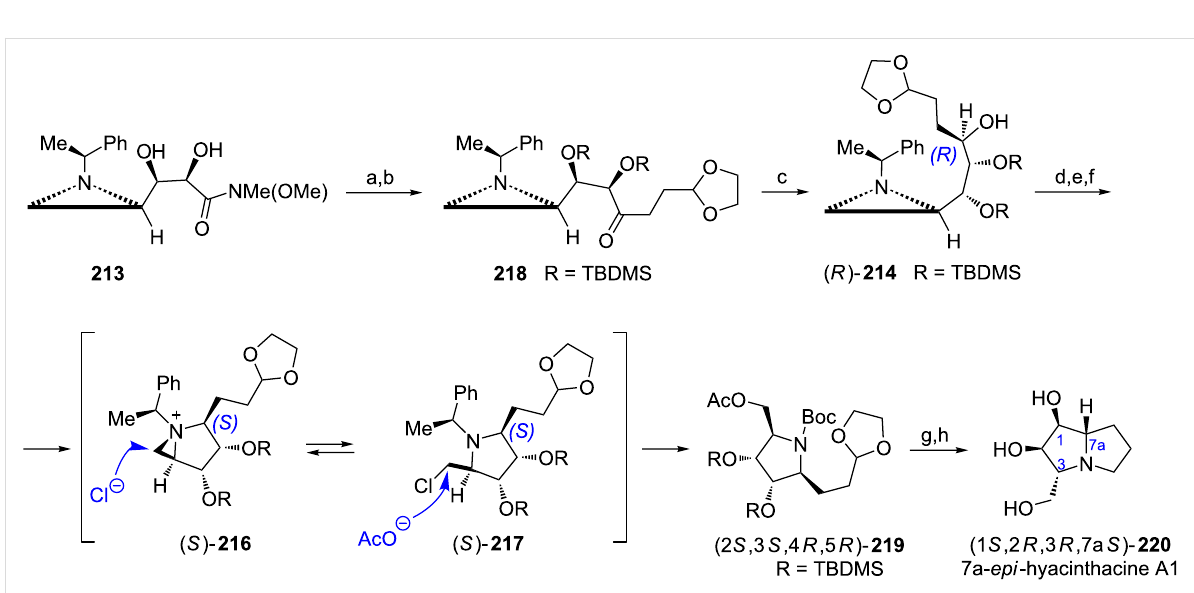
Scheme 54: Syntheses of 1-deoxy- ᴅ - galacto -homonojirimycin (2 R ,3 S ,4 R ,5 S )- 211 . Reagents and conditions: a) MeONHMe, iPrMgCl, THF, 0 °C, 15 min; b) OsO 4 , NMO, acetone, 0 °C to rt, 6 h; c) TfOTBDMS, 2,6-lutidine, CH 2 Cl 2 , − 78 °C to rt, 2 h; d) DIBAL-H, hexane, − 40 °C, 8.5 h; e) 2-(2- bromoethyl)-1,3-dioxolane, Mg, THF, rt, 0.5 h; f) MsCl, TEA, DMAP, CH 2 Cl 2 , 0 °C to reflux, 2 h; g) AcOCs, DMF, 100 °C, 3 h; h) H 2 , 20% Pd/C,